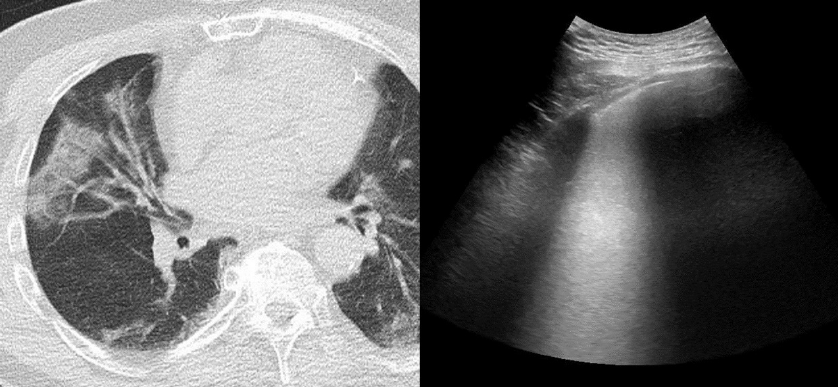
Figure 2. Left panel: CT scan demonstrating bilateral GGO with tendency of consolidation. Right panel : LUS demonstrating thickening of the pleural line and intercostal predominantly coalescent B-lines or B2 pattern .